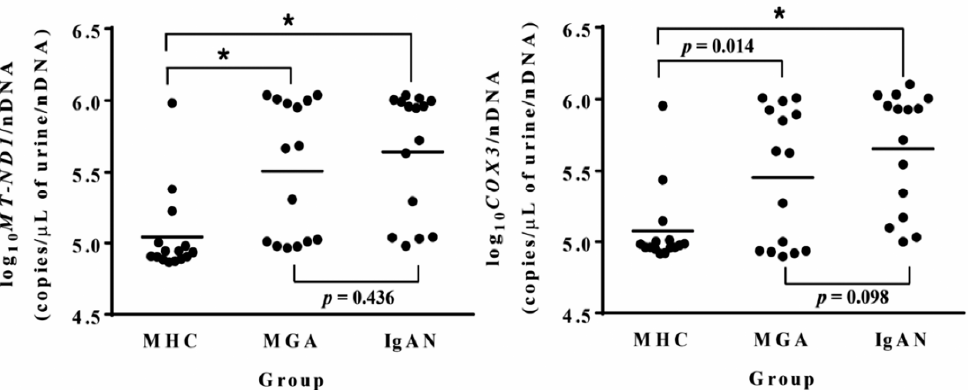
Figure 3. Urinary mitochondrial DNA copy numbers in the matched healthy control (MHC), minor glomerular abnormality (MGA), and immunoglobulin A nephropathy (IgAN) groups. Data were analyzed by the Mann – Whitney test. * p < 0.001. MT-ND1 , mitochondrially encoded NADH dehydrogenase 1; COX3, cytochrome c oxidase subunit III.